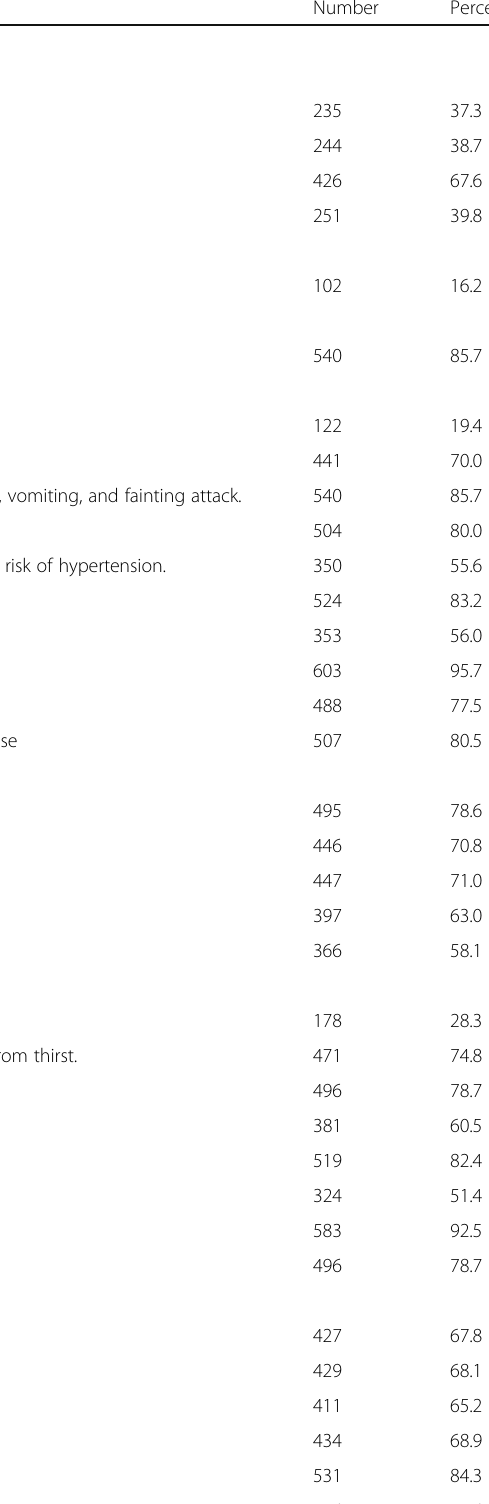
Table 3 Accuracy rate of response to each knowledge